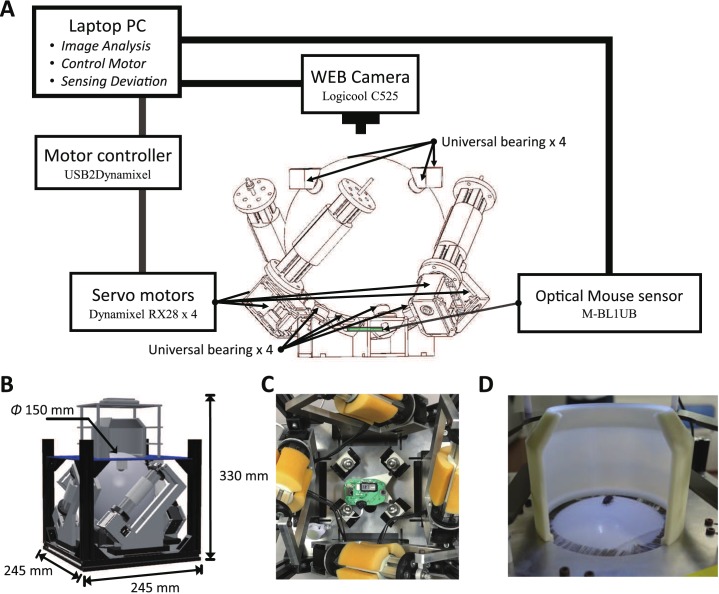
System diagram of the ANTAM (animal tracking device-accompanied mobile suit).(A) System chart with wireframe model of the mechanical part of ANTAM. (B)3D model of the ANTAM (C) The optical mouse sensor is fixed under the sphere, and four universal bearings are arranged around and support the sphere. (D) A photograph of a pillbug walking freely on the ANTAM during moving compensation.